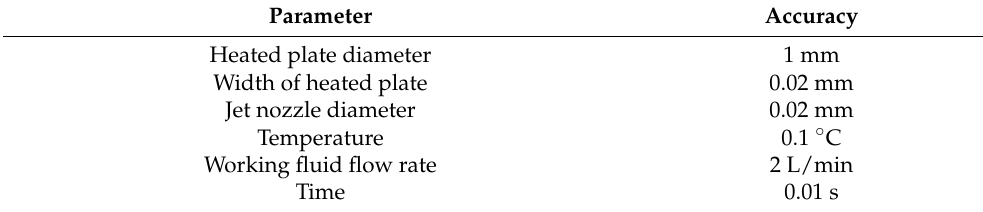
Table 3. Errors in measurement.